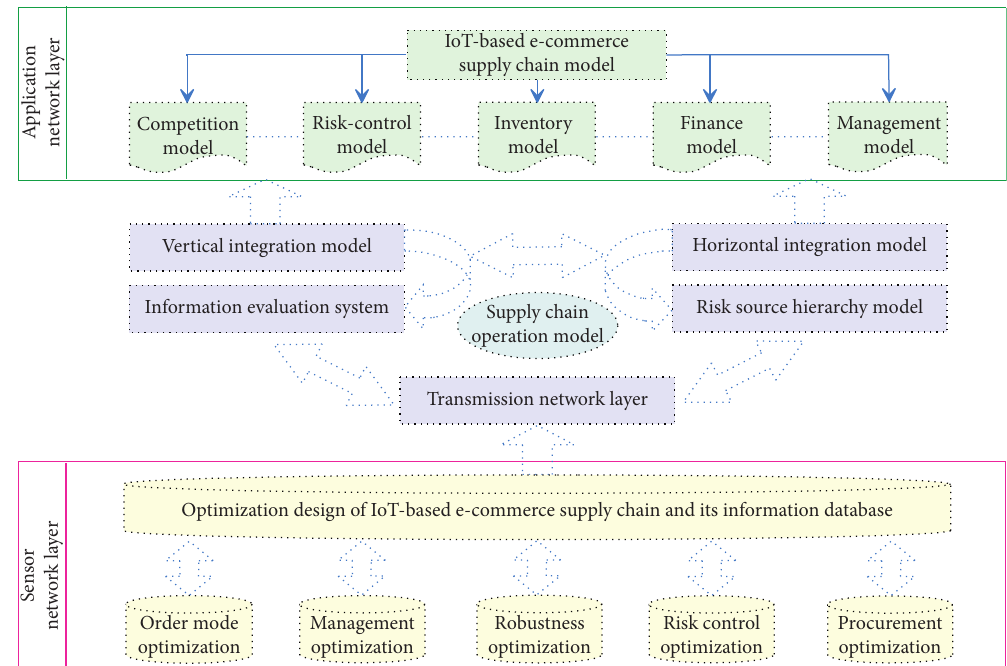
Figure 1: Framework of the IoT-based e-commerce supply chain